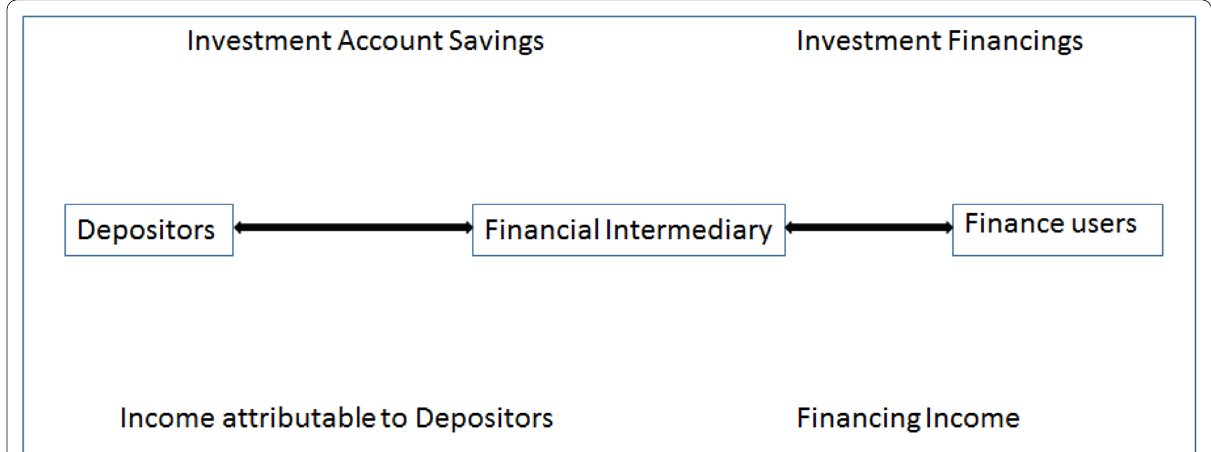
Figure 1 Financial intermediation for Islamic banks. Adopted from Batchelor